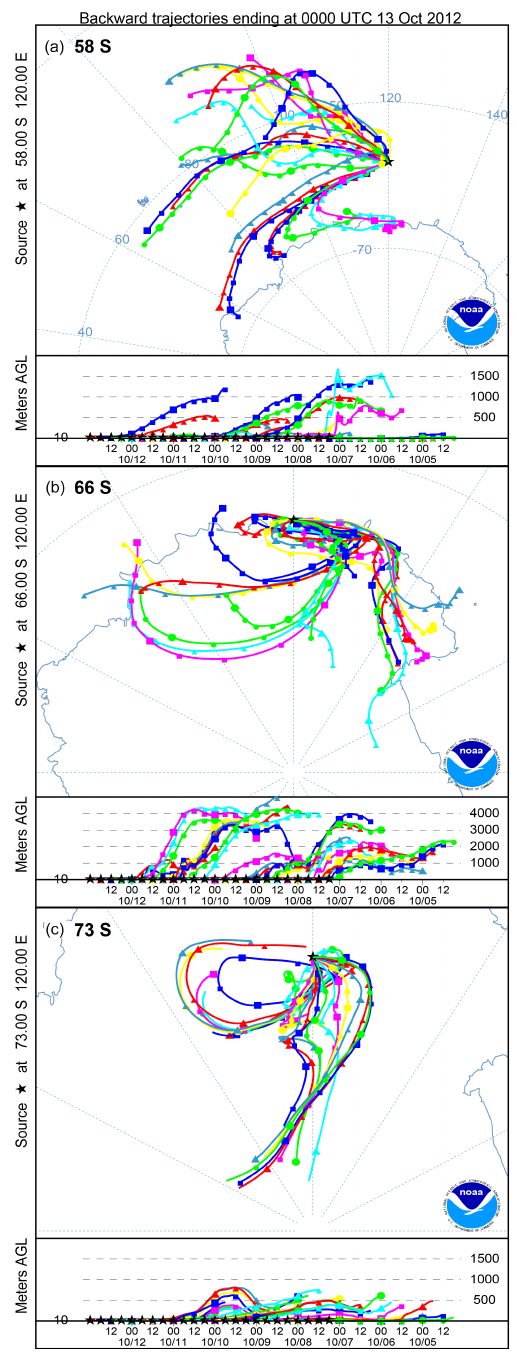
Figure 4. Three-day (72h) back trajectories calculated from 10m above mean sea level using the HYSPLIT model with GDAS input meteorology for a 7-day period ending at midnight on 13 October 2012. All trajectories have endpoints at 120 ◦ E, and differing lati- tudes: (a) (58.0 ◦ S), (b) (66 ◦ S) and (c) (73.0 ◦ S). Changes in colour help identify different trajectory ending